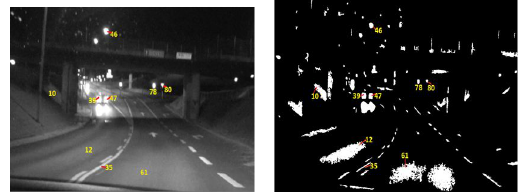
Figure 5. Features based on